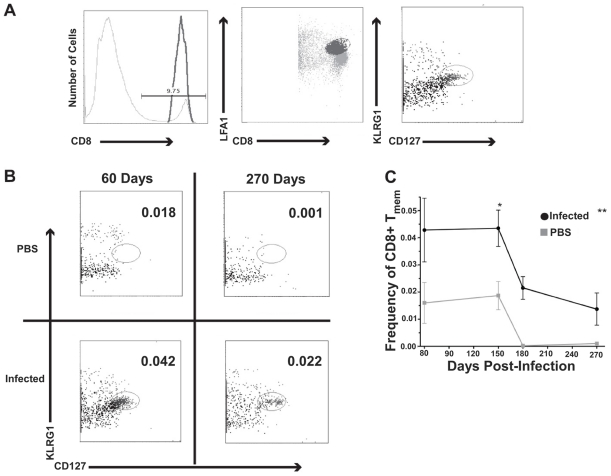
Phenotyping CD8+ Tmem.A) Representative flow cytometric gating strategy of splenic Tmem, CD8+ LFA1hiCD127hiKLRG1lo at day 60 post-infection. From left to right the panels show gating of CD8+ cells, LFA1hiCD8+ cells, and CD8+ LFA1hiCD127hiKLRG1lo cells from analysis of 500,000 to 1 million cells. B) Plots showing the absence of Tmem in age-matched uninfected mice (PBS injected) and the presence of Tmem in mice with chronic brucellosis. C) Frequency of splenic CD8+ Tmem over time. ANOVA was performed to determine if infection with B. melitensis had a statistically significant impact on the presence of CD8+ Tmem. **p<0.002 for infected animals at the different days except for day 150 where p<0.05.